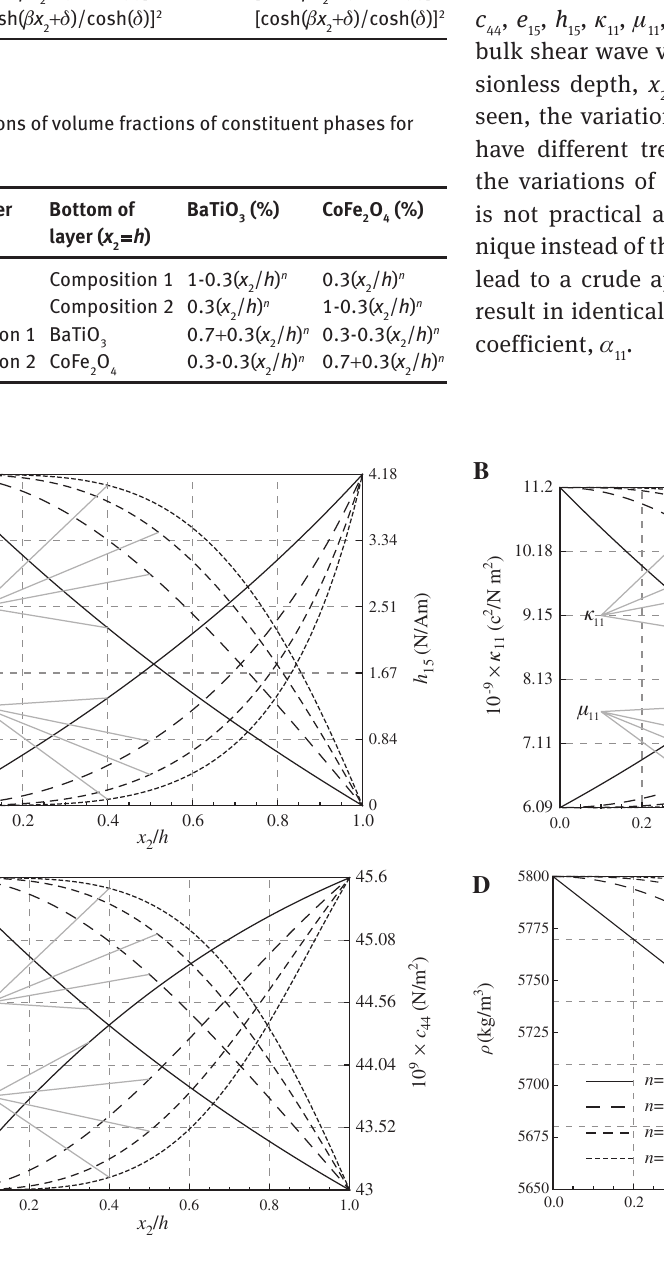
Figure 2: Material properties variation as functions of the dimensionless depth, x (C) c and α , (D) c . 44 11 sh